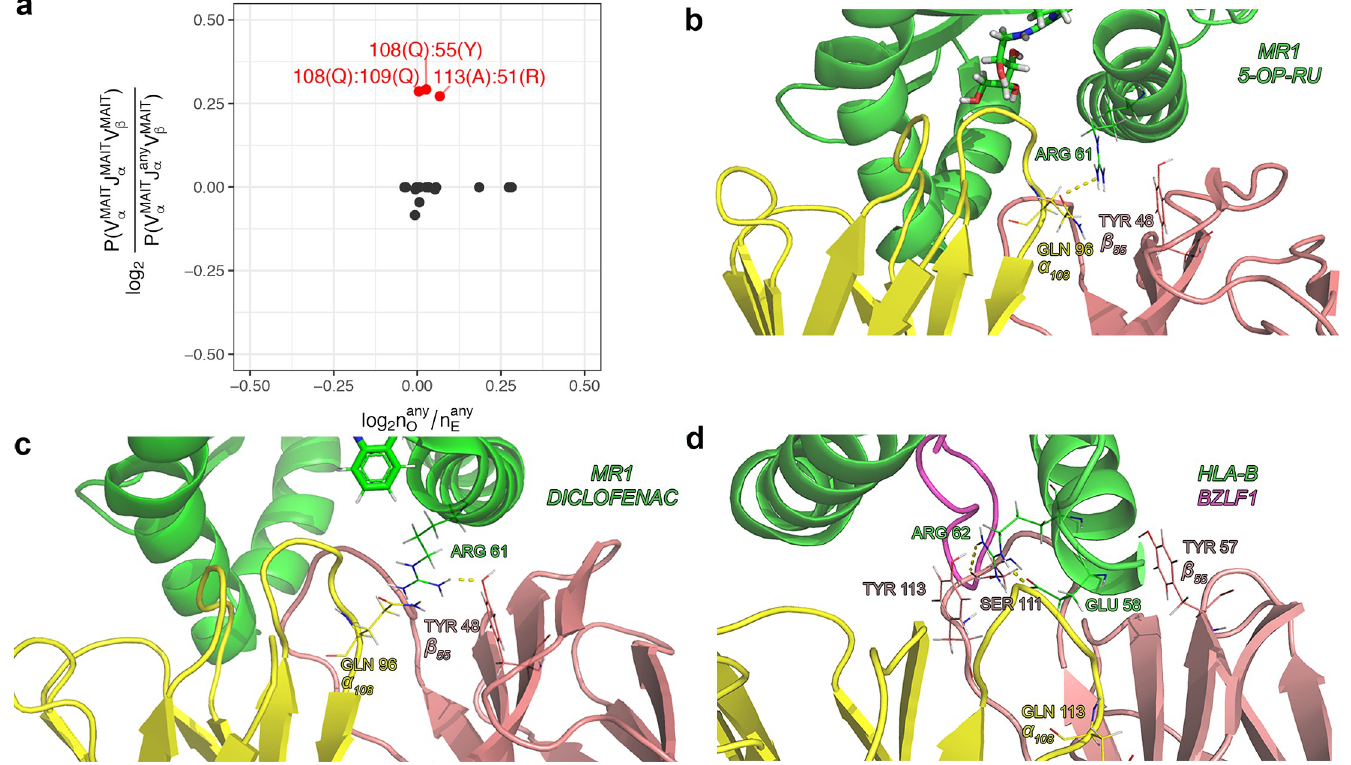
Fig 7. Characteristic residue contacts of MAIT TCRs. a. Scatter-plot of amino acid pair enrichment at contacting residues for the J α gene choice of MAIT T-cells versus overall enrichment observed for given contact residues in the PairSEQ dataset. Y axis shows the log ratio of amino acid pair probabilities for V α J α V β combinations corresponding to MAIT T-cells and those with a free choice for the J α gene. X axis shows observed to expected amino acid pair count ratio at contacting residues in the PairSEQ dataset. Residue pairs with enriched amino acid pairs coming from MAIT J α gene choice (y > 0.25, corresponding to ~19% increase in frequency) are colored in red and labeled. Not that overall enrichment for corresponding amino acid pairs in the PairSEQ dataset is relatively moderate (x < 0.125, corresponding to ~9% increase in frequency). b.-d. Structural data showing Glutamine (GLN, Q) at α 108 and Tyrosine (TYR, Y) at β 55 interacting with an Arginine (ARG) of MHC alpha-1 helix domain in the MAIT:MR1 complex. MR1 complex structures are shown in b ( 4pj7 ) and c ( 5u1r ), d shows an non-MAIT TCR (having the same amino acids at α 108 and β 55 ) in complex with MHCI ( 4jry ). Polar contacts between GLN:ARG and TYR:ARG are shown with dotted lines in b and c , but are absent in d . PDB structure chain coloring: green for MHC, yellow for TCR α and pink for TCR β ; antigen peptide in d is shown with purple.